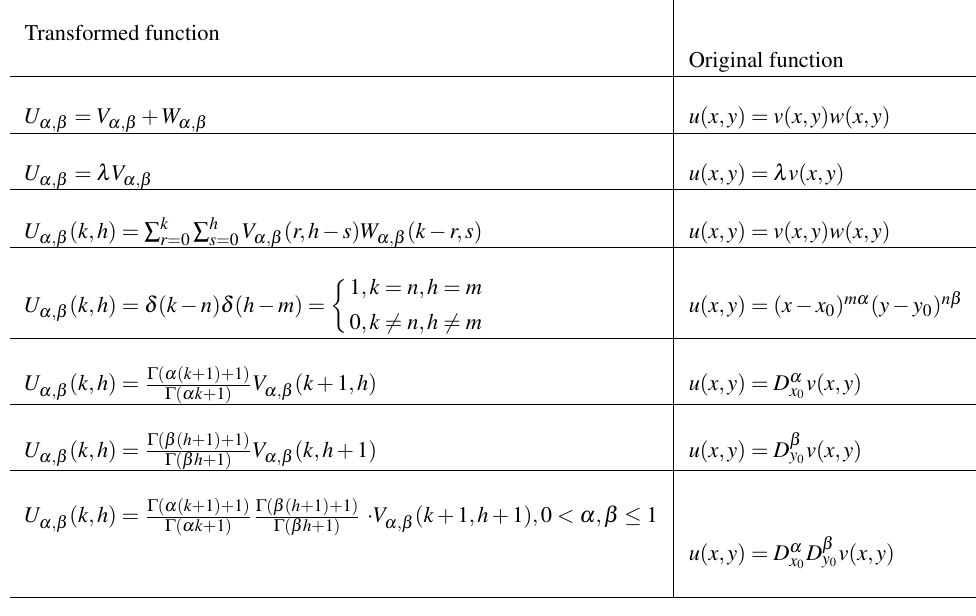
Transformed function